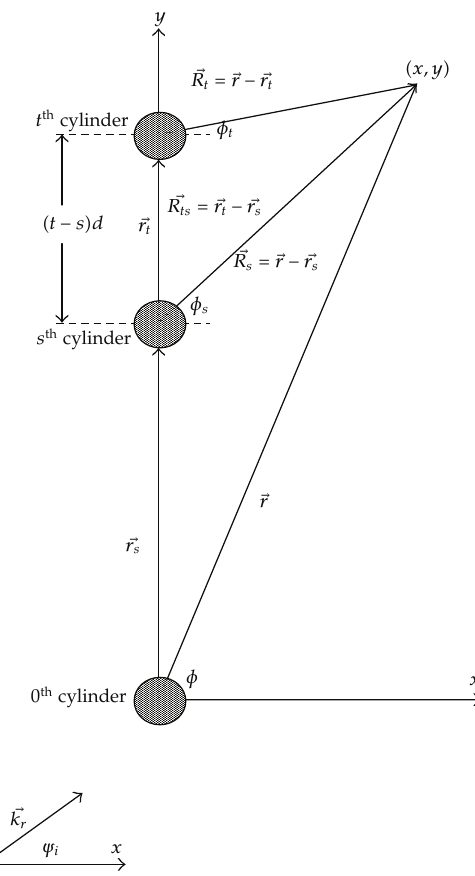
Figure 2: The geometry of the infinite grating problem (cid:4) top view (cid:5)